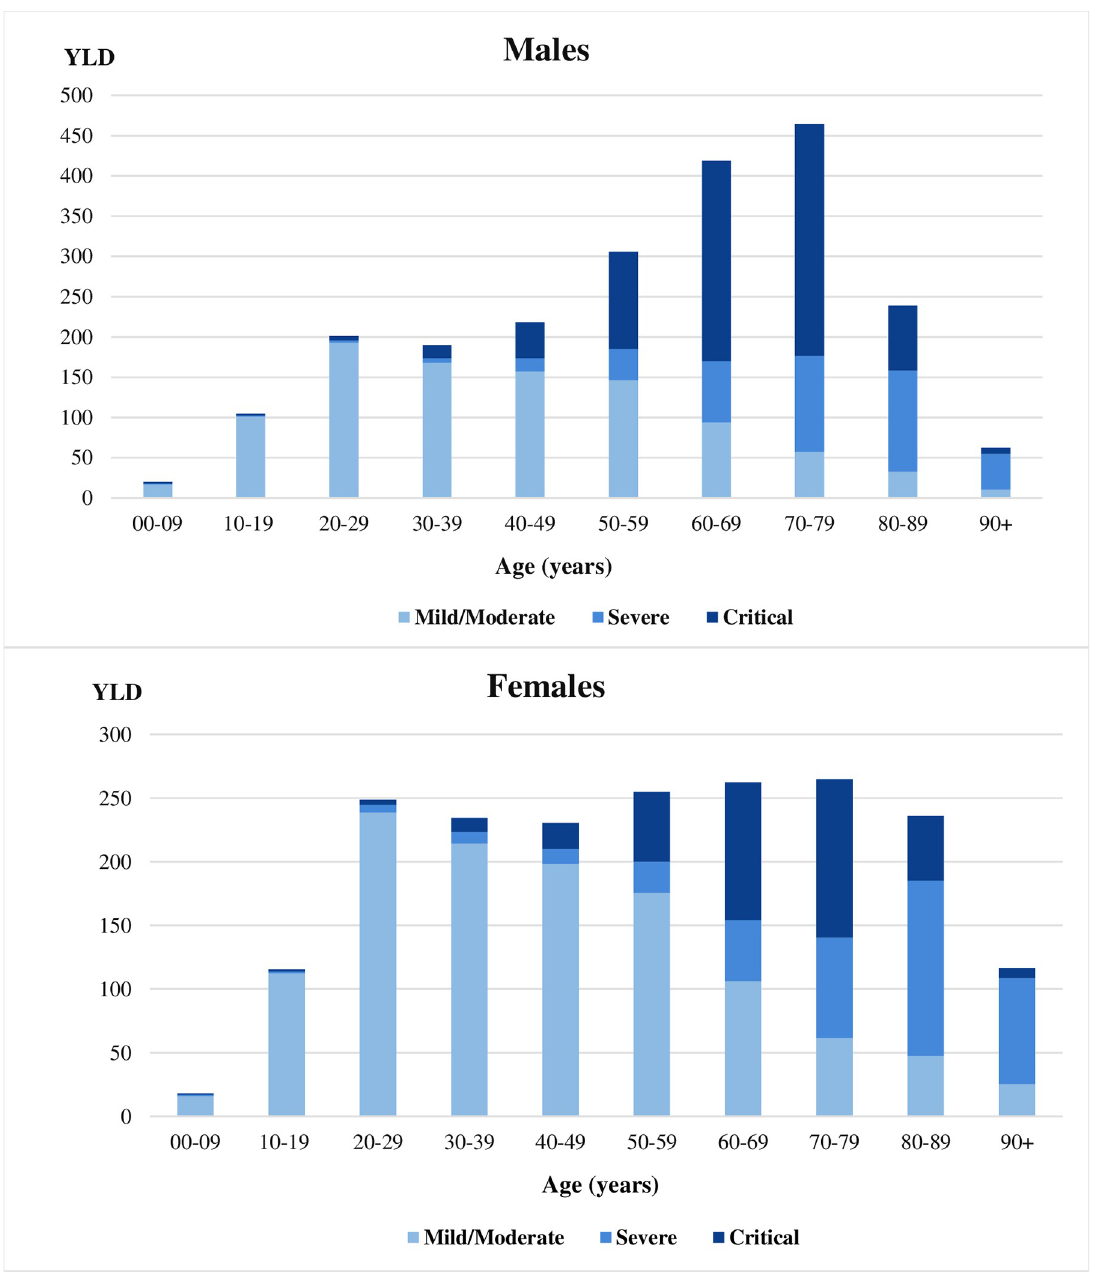
Fig 3. Years lived with disability due to acute symptomatic COVID-19 infections in France in 2020 by age, sex and severity level.